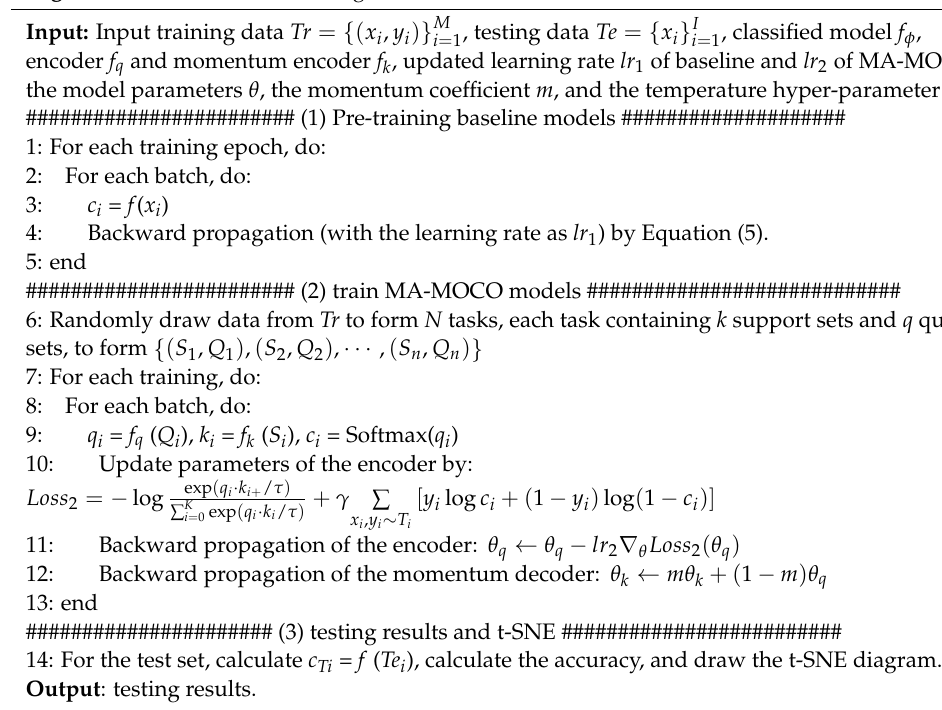
Algorithm 1: One-Shot Fault Diagnosis Based on